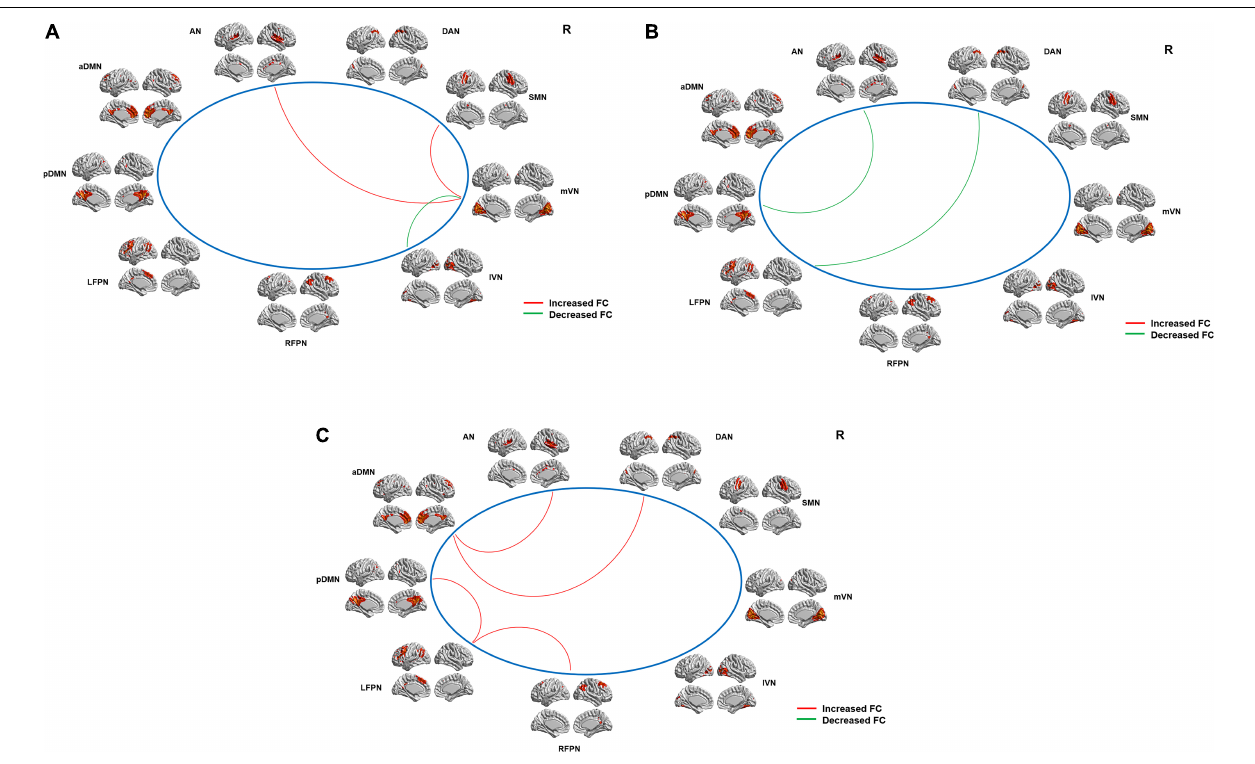
FIGURE 4 | Intergroup differences in internetwork FC between the tinnitus patients and HCs and between the patients before and after sound therapy. (A) Compared with the HCs, the tinnitus patients exhibited a decreased (i.e., positive) (mVN and lVN) or an increased (i.e., less negative) (mVN and SMN; mVN and AN) internetwork FC at baseline. (B) Compared with HCs, tinnitus patients showed a decreased (i.e., positive) (AN and pDMN; DAN and LFPN) internetwork FC after sound therapy. (C) Compared with the patients at baseline, the tinnitus patients exhibited increased (i.e., negative) (LFPN and pDMN; LFPN and RFPN; aDMN and AN; aDMN and DAN) internetwork FC after sound therapy. AN, auditory network; aDMN, anterior default mode network; pDMN, posterior default mode network; LFPN, left frontoparietal network; RFPN, right frontoparietal network; lVN, lateral visual network; mVN, medial visual network; SMN, sensorimotor network; DAN, dorsal attention network; FC, functional connectivity, HC, healthy control.The red line represents positive FC; the green line represents negative